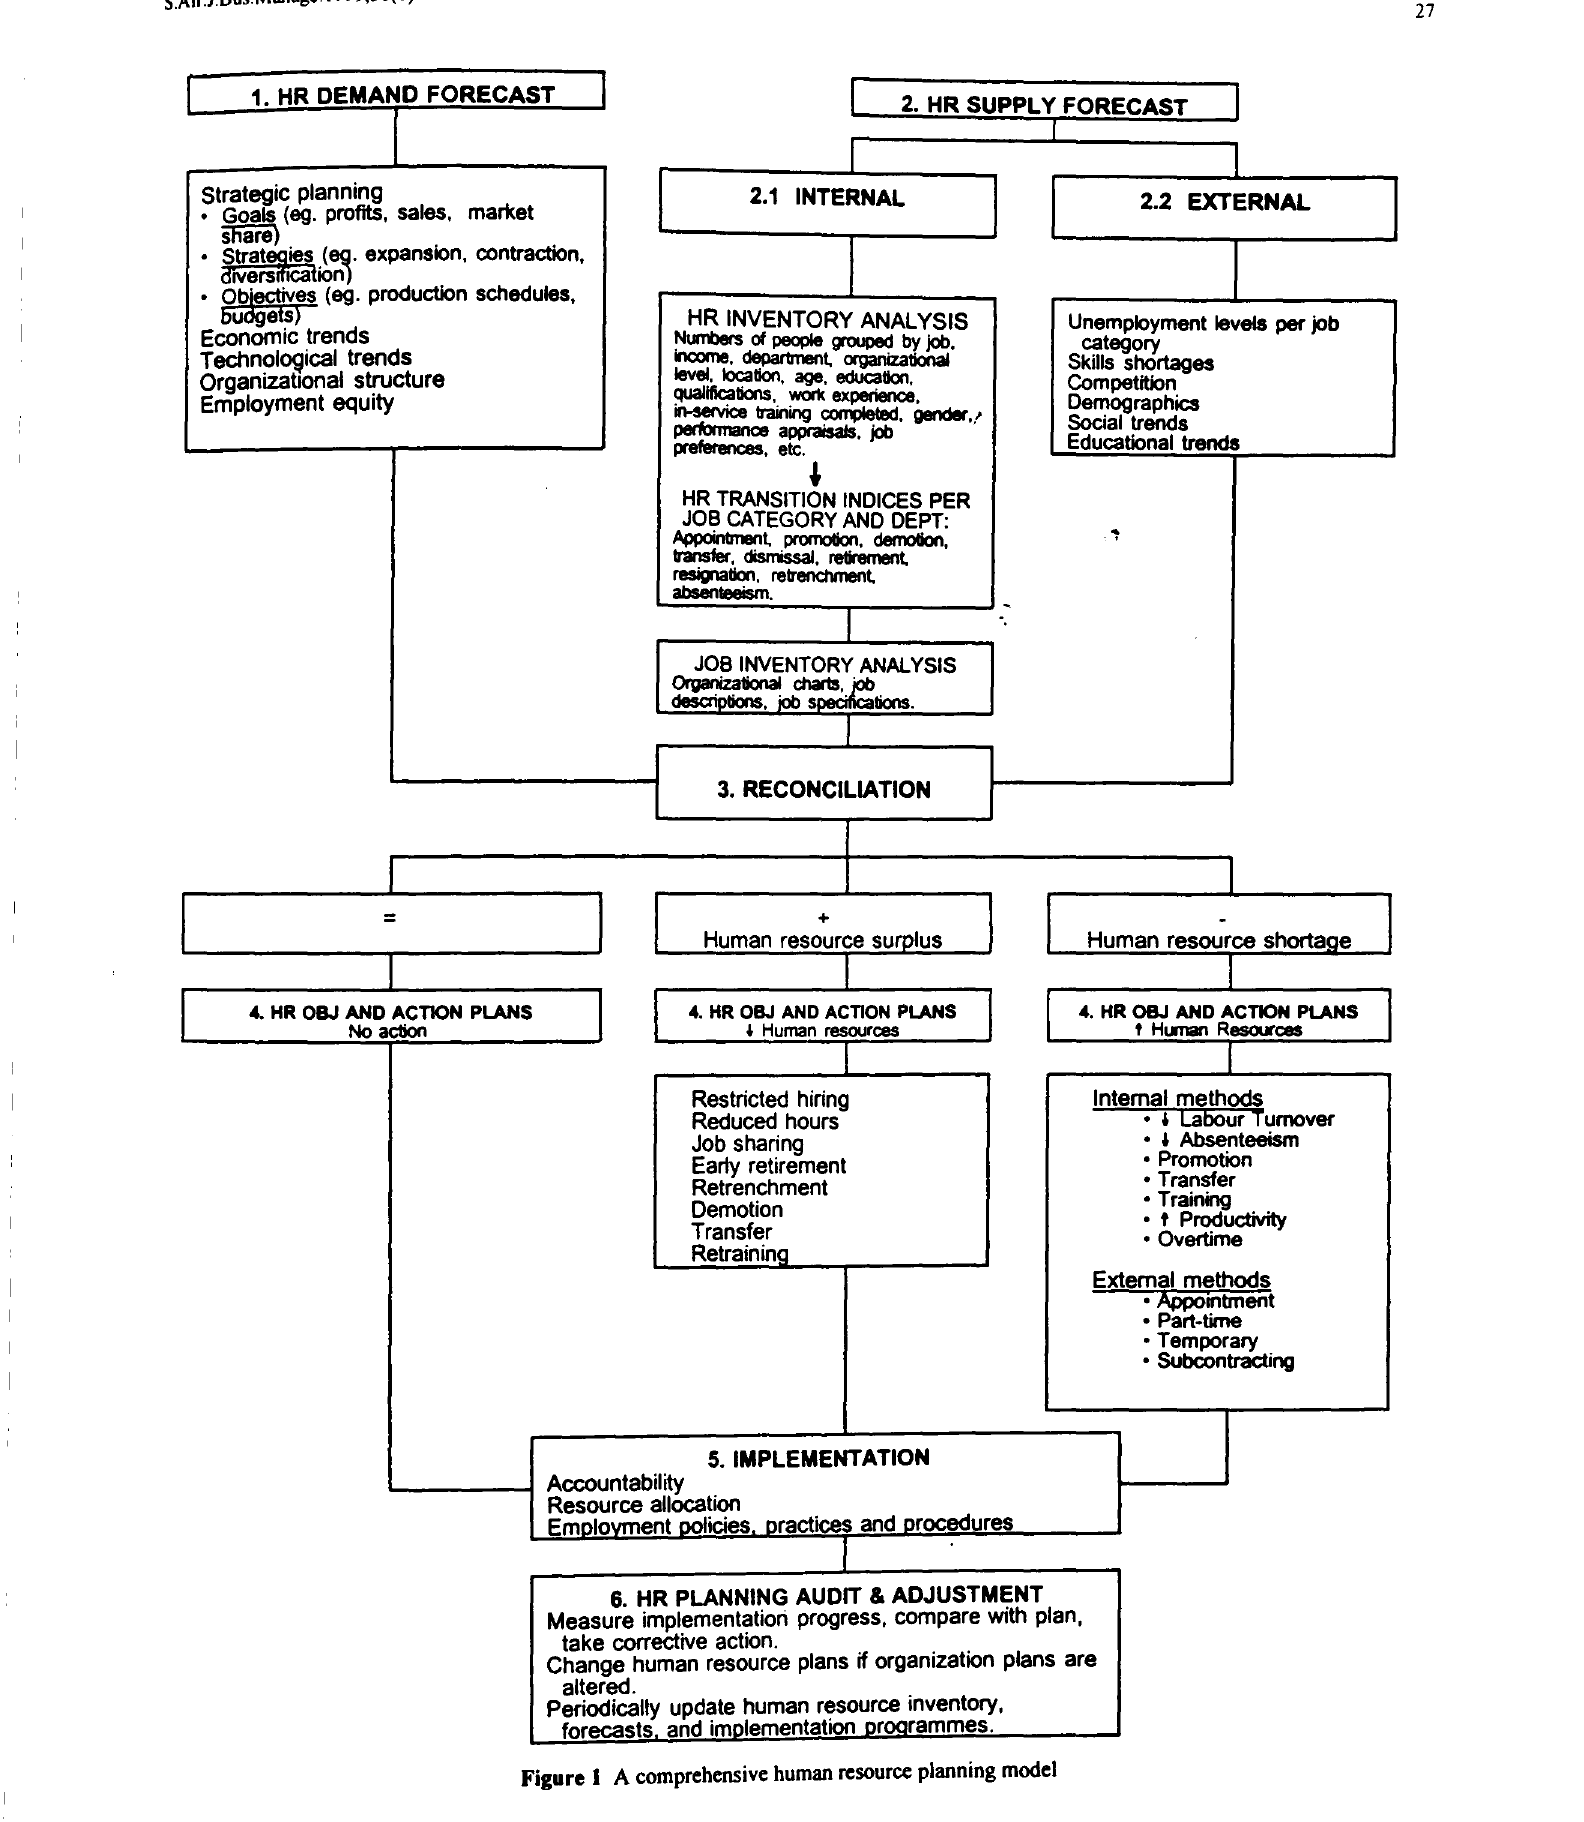
Figure 1 A comprehensive human resource planning model Phase 2. I Internal human resource supply forecast' during the forecast period, as well as a forecast of the This phase entails an analysis of the inventory of the current availability of human resources external to the organization workforce and the current jobs in the from which needed people can be drawn.